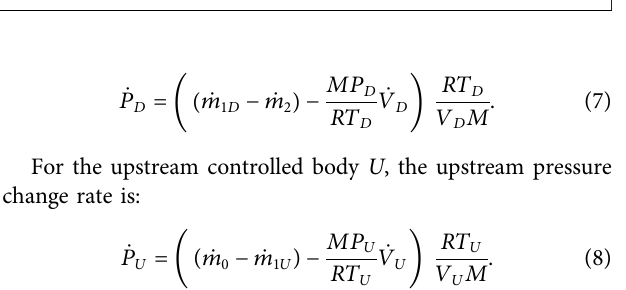
FIGURE 5 | Theoretical calculation model of shock wave